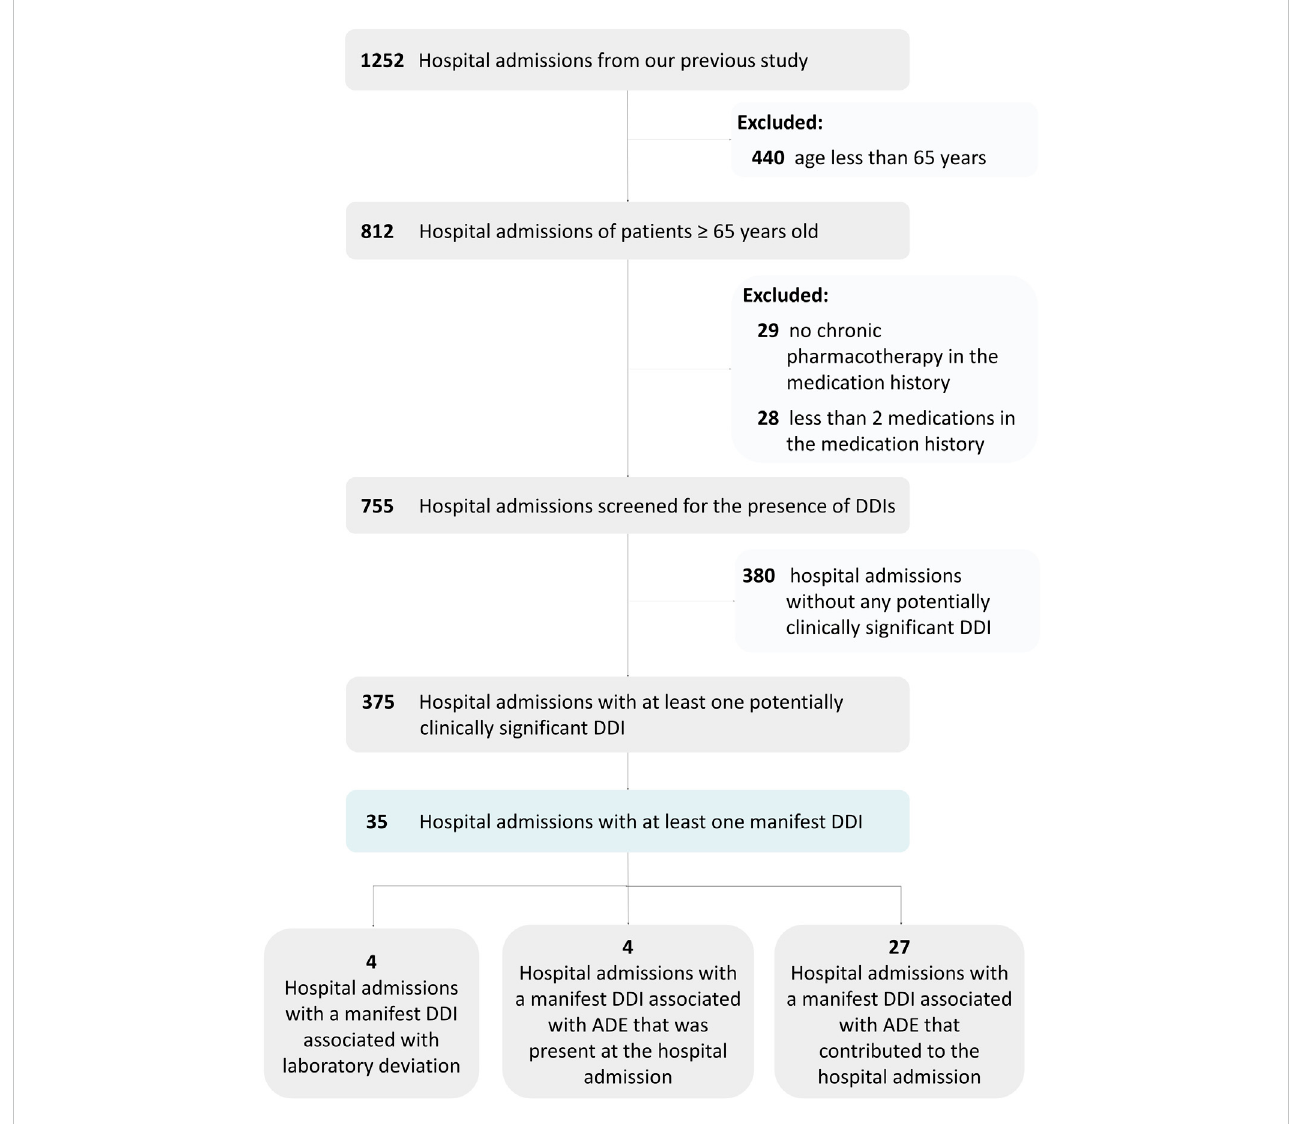
FIGURE 1 Flow chart showing the number of hospital admissions in each